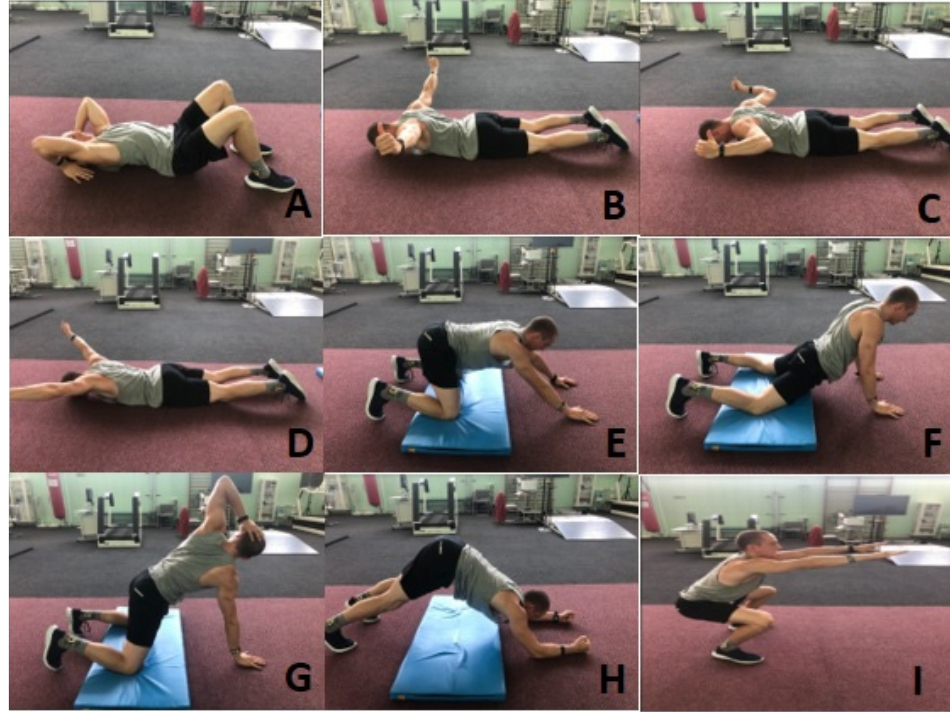
Figure 2. Warm-up protocol. ( A – D ) Mobilization of the upper limb joints; ( E , F ) mobilization of the hip joints; ( G , H ) mobilization of the thoracic spine; ( I ) squat without loading.